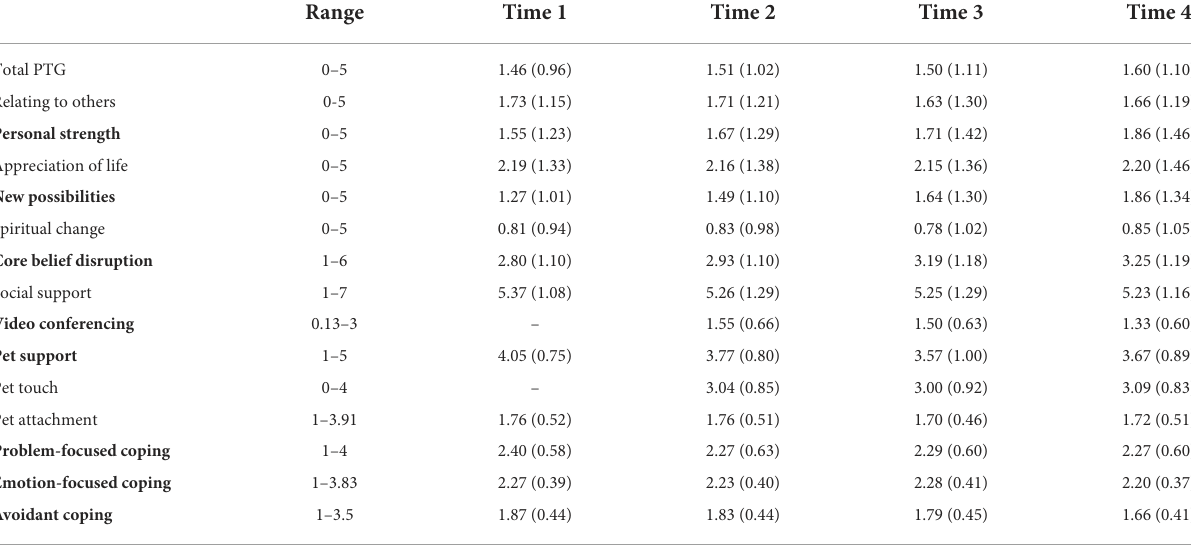
TABLE 3 Changes across